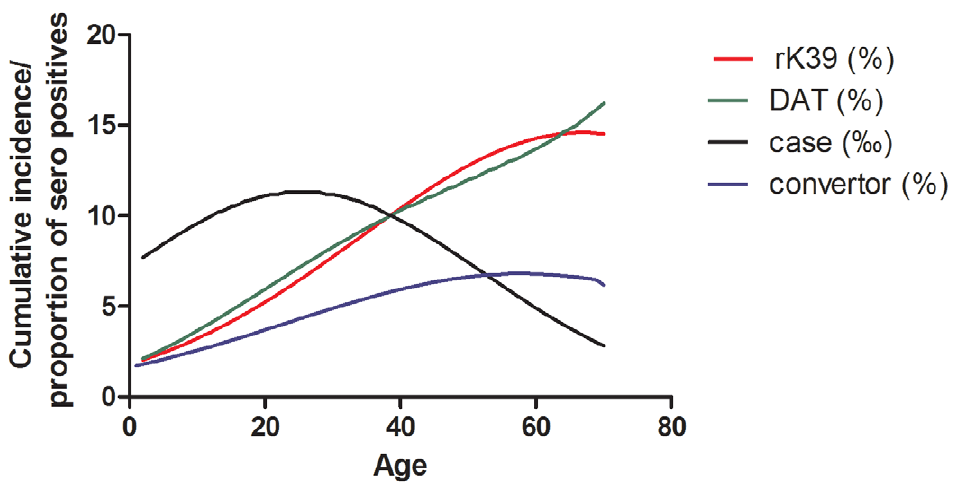
Figure 5. Probability of VL, sero conversion, and sero-prevalence by age group. Cumulative VL incidence over the 2 K year period preceding the first round sero-survey, probability of DAT and rK39 positivity during the first round sero-survey, and probability of sero-conversion on either DAT or rK39 during the 12-months interval between the first and second round survey have been plotted by age.